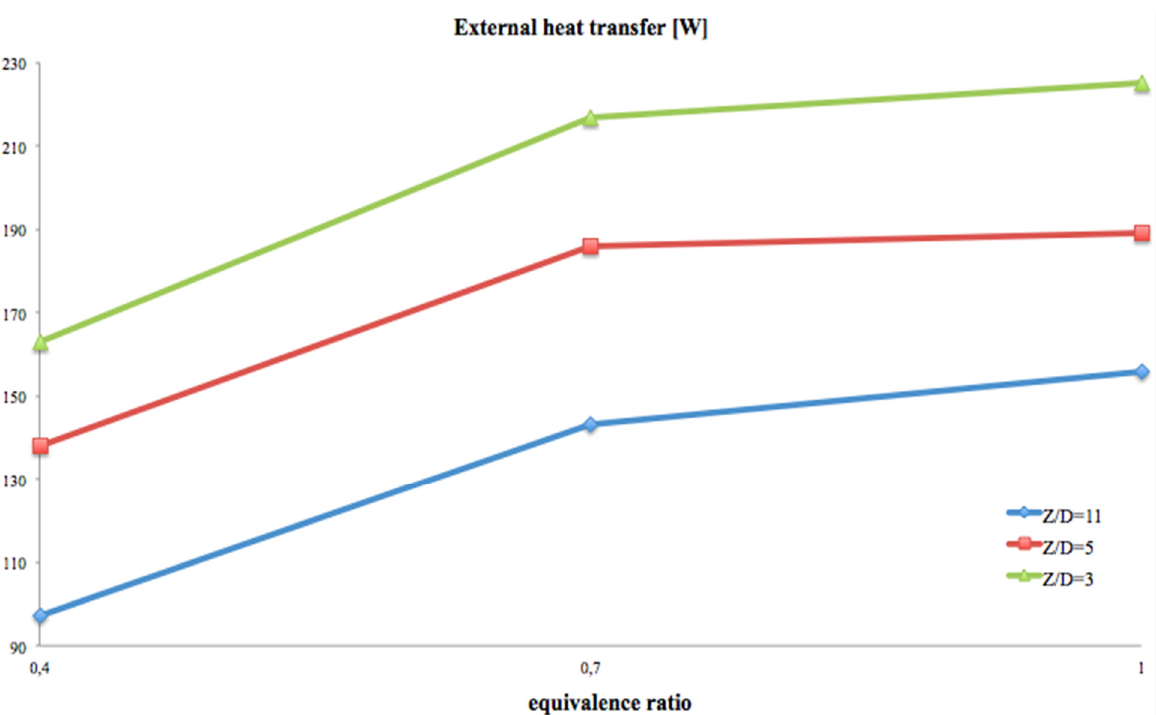
Figure 6. External heat transfer